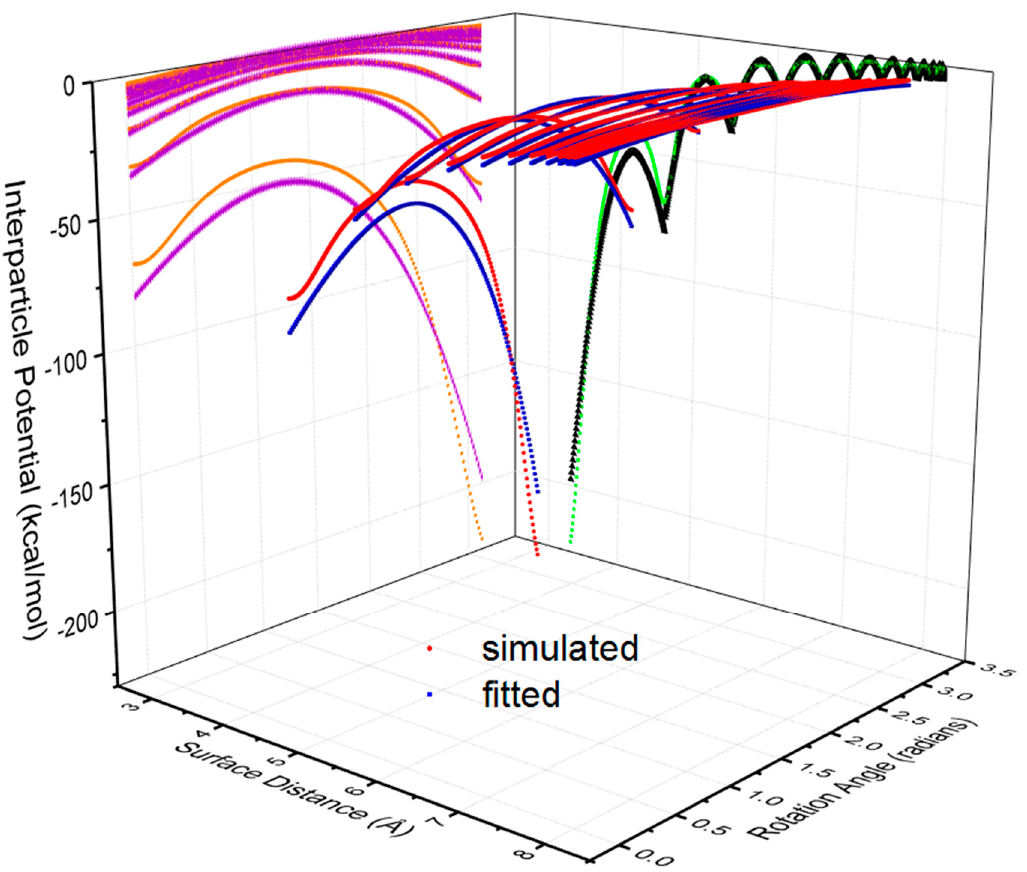
Figure 6. 3D image of simulated (in red) and fitted (in blue) curves of interparticle potentials of AuNRs with a diameter of 2 nm and aspect ratio of 4 with respect to surface separation and rotation angle. Their projected curves indicate the dependence of potential on rotation angle (in orange and purple) and surface separation (in green and black), respectively Table 1. Constants for the fitted interaction potential models of AuNRs with a diameter of 2 nm and different aspect ratios (L/D).